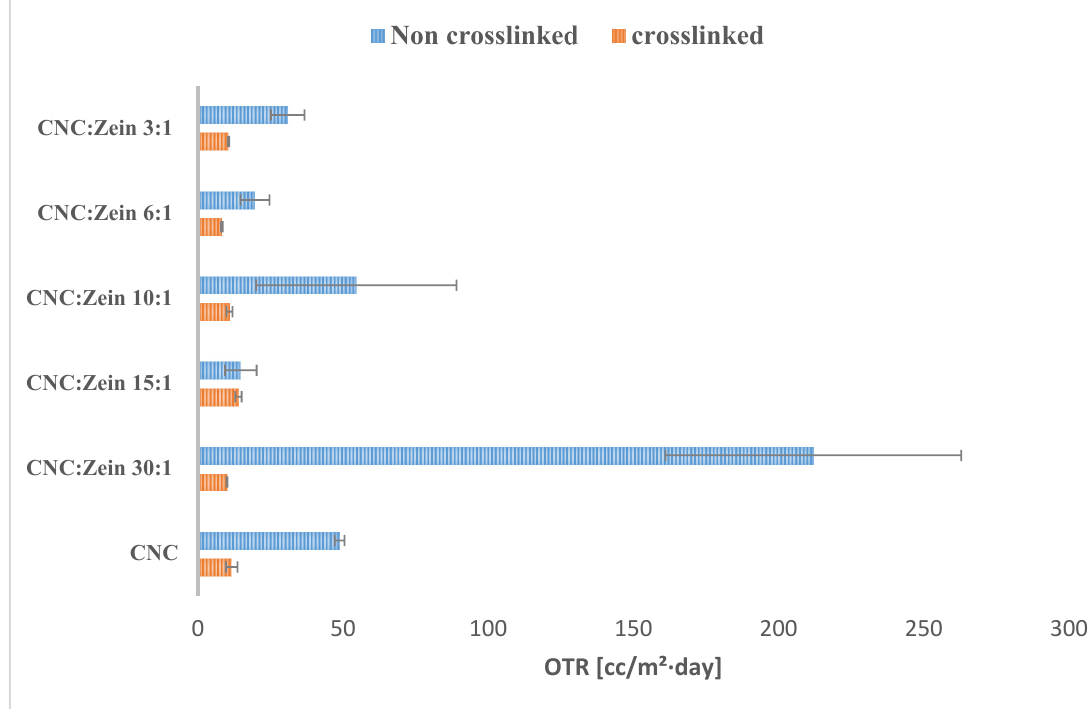
Figure 7. Comparative OTR of various films samples. All samples are coated on a 30 µm corona treated biaxially-oriented polypropylene (BOPP) film.